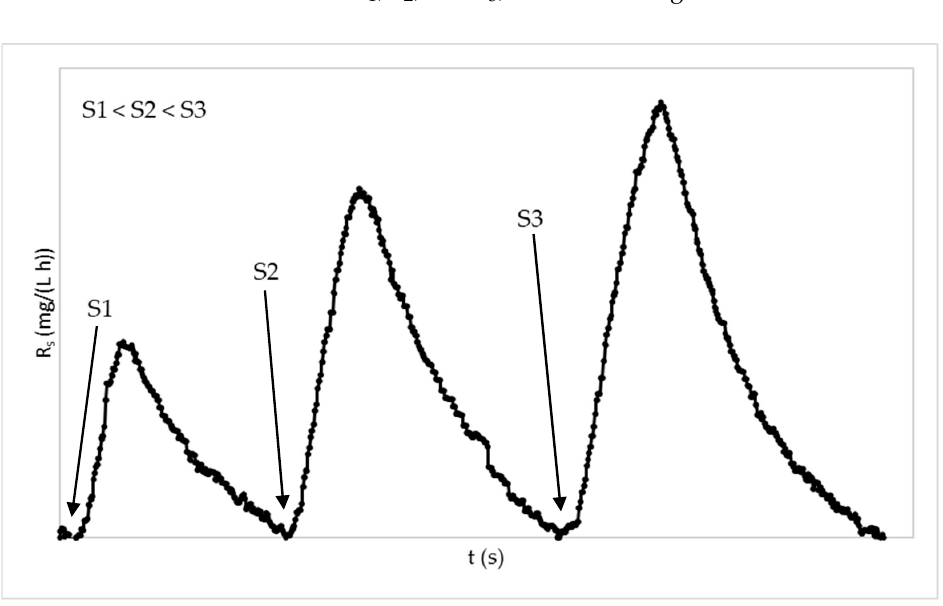
Figure 2. Evolution example of dynamic oxygen uptake rate (R s ) in exogenous respirometric exper-